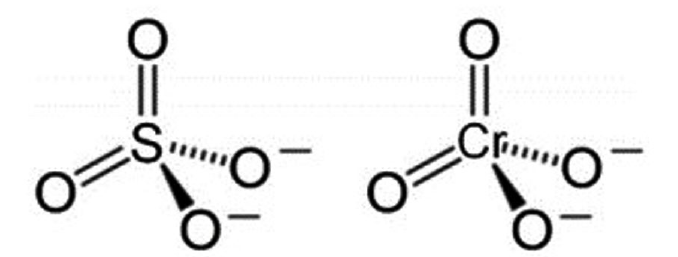
Fig. 1. Structural similarity of chromate and sulfate ions; adapted from Thatoi et al.